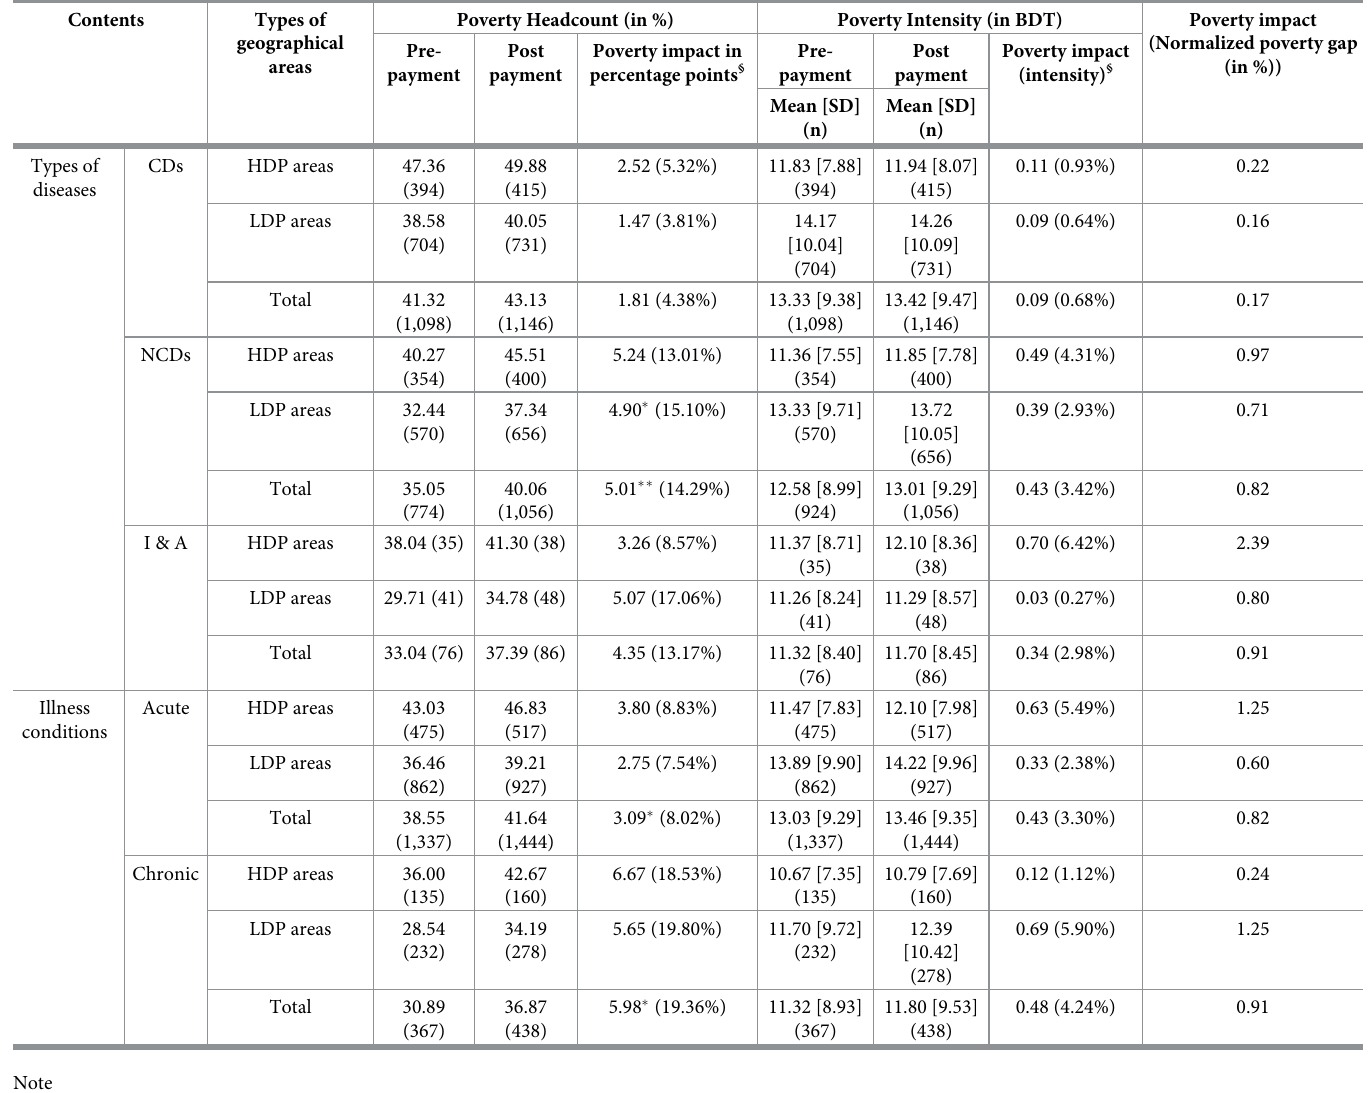
Table 6. Impact of OOP payments on poverty by types of diseases/illness conditions and geographical